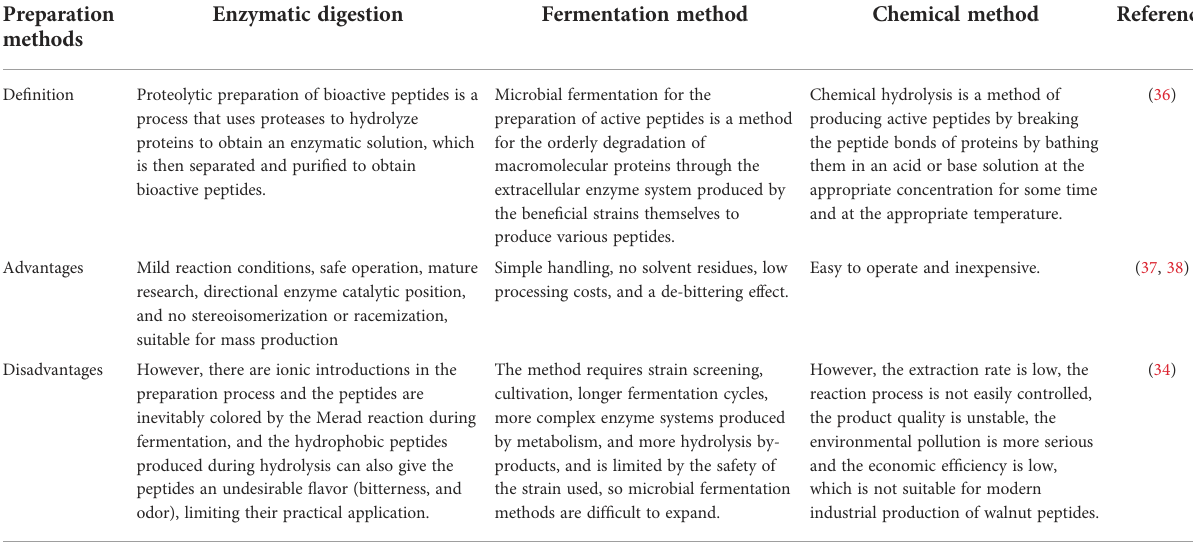
TABLE 3 Comparison of walnut peptide preparation